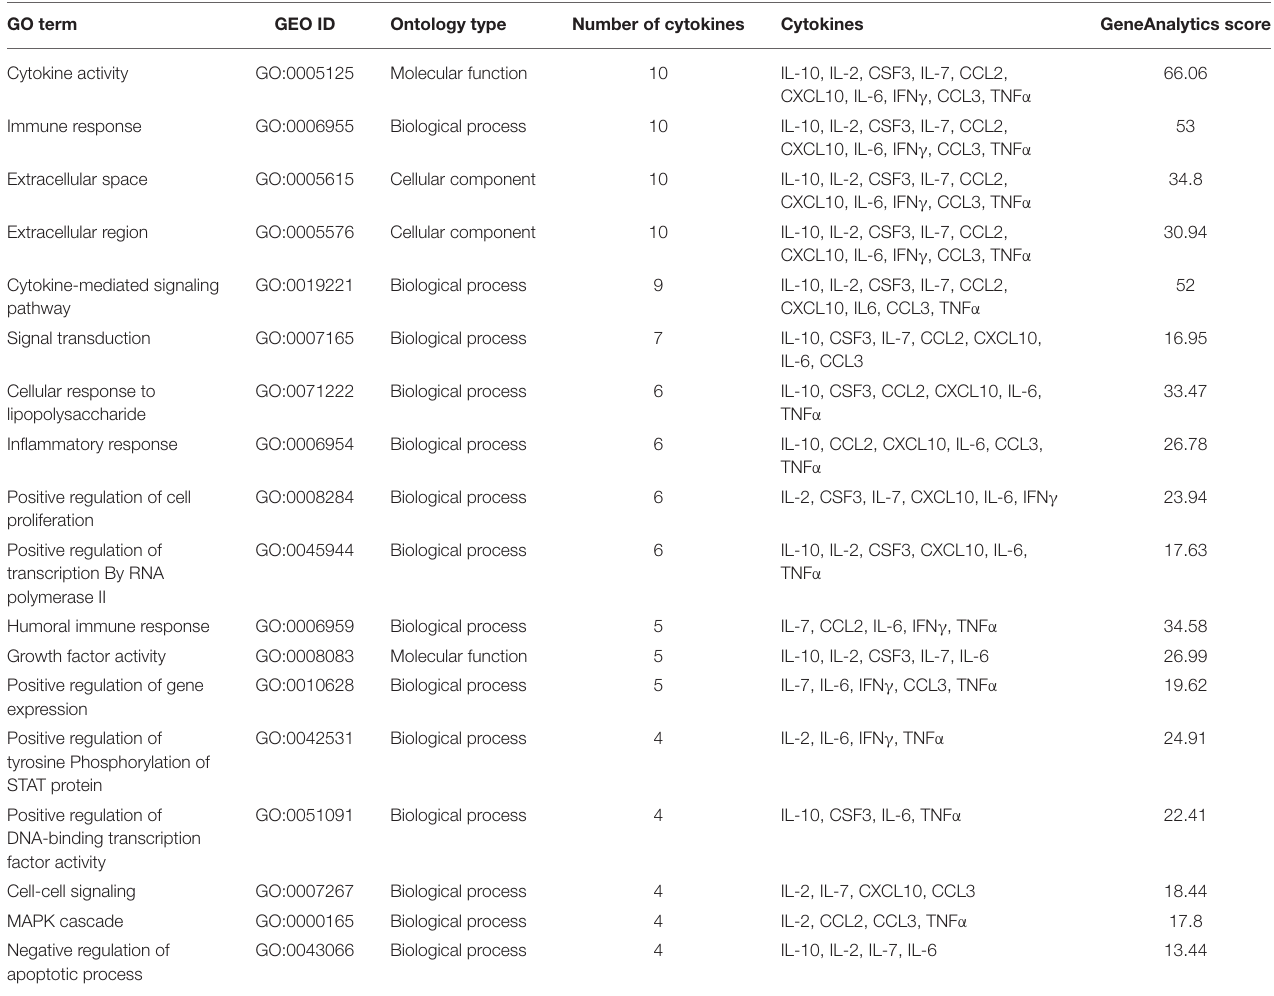
TABLE 4 | Gene ontology terms associated with cytokines significant to COVID-19 cytokine